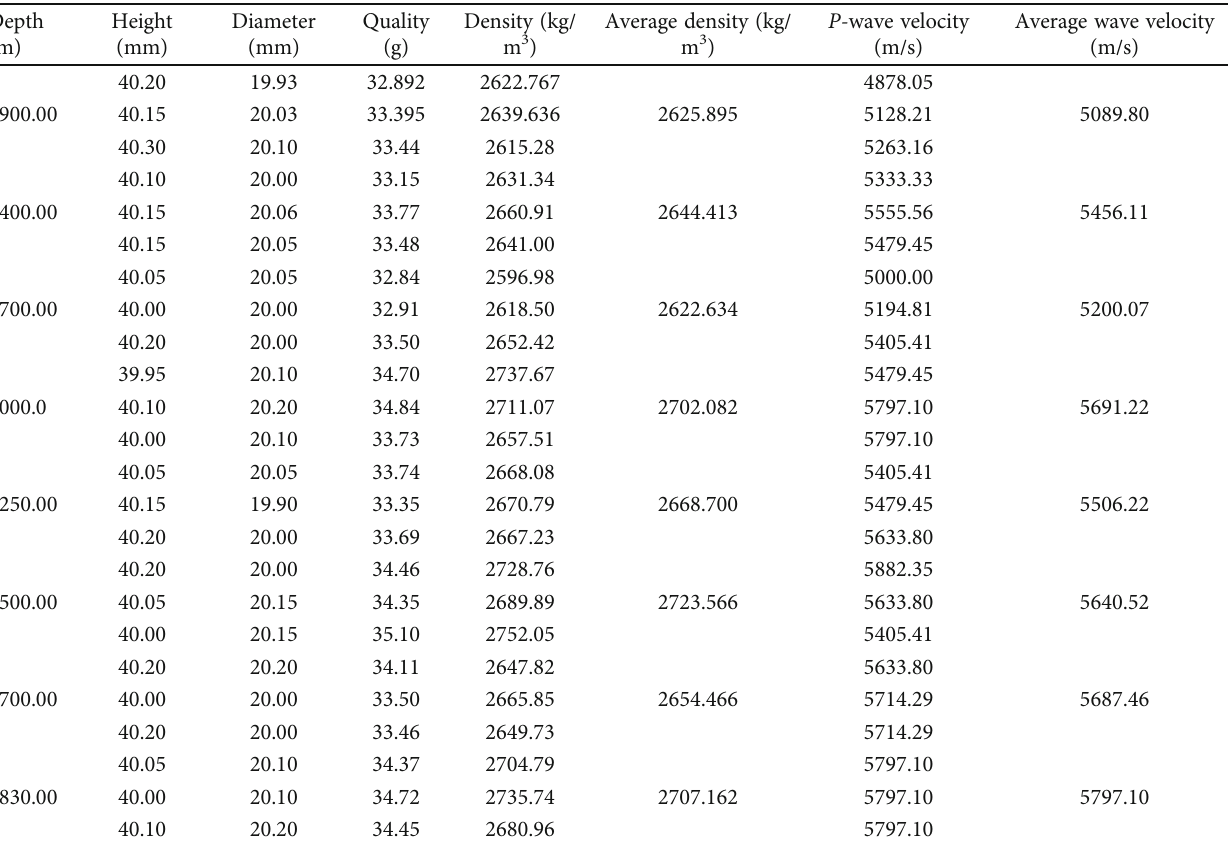
Figure 5: Variation of minerals with di ff erent phases with depth. Table 2: Results of density and wave velocity of rocks at di ff erent